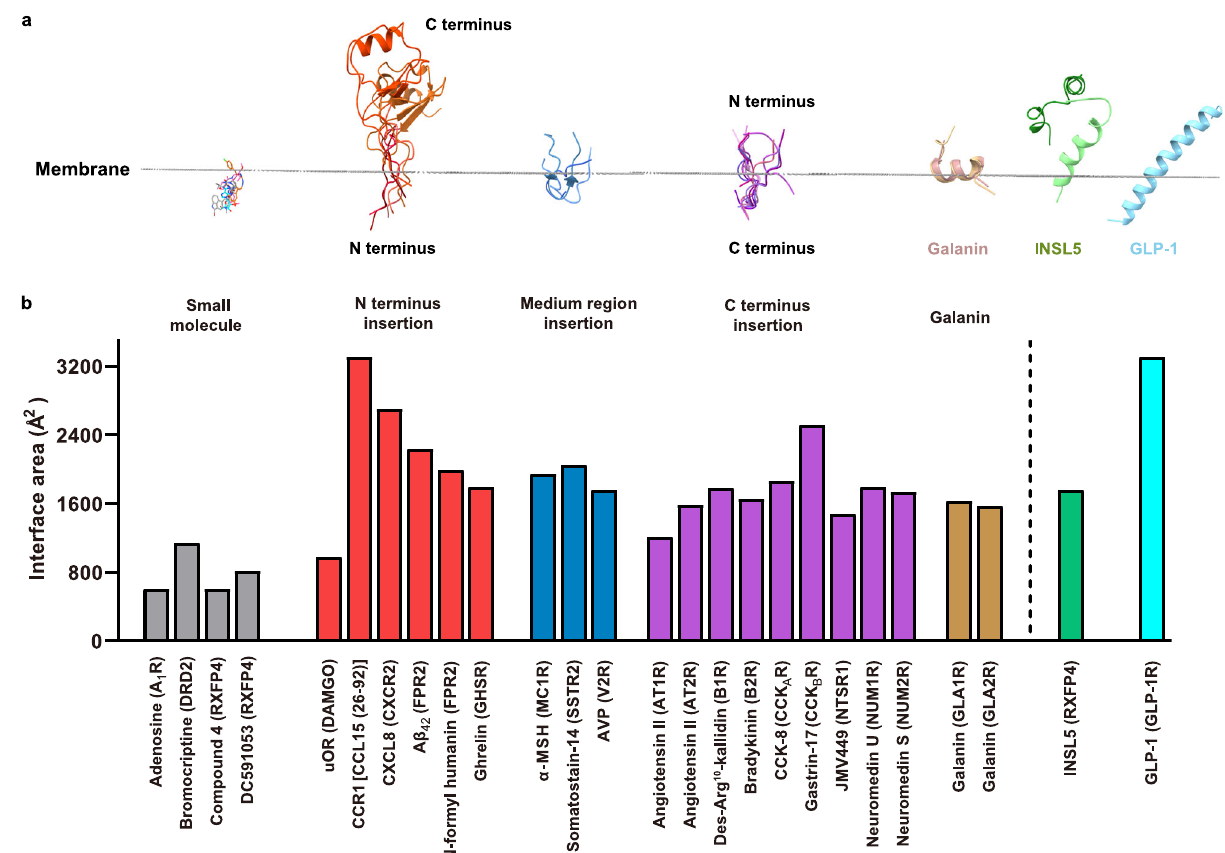
Fig. 5 | Comparison of ligand binding modes. a Conformations of different ligands during their insertion into the orthosteric pocket. The posture of INSL5 embedded in the membrane was compared with small molecules, galanin, GLP-1 andotherpeptideswithNterminus,mediumregionandCterminusinsertionsinto theTMDcore.Receptorstructureswereomittedforclarity. b Theinterfaceareaof